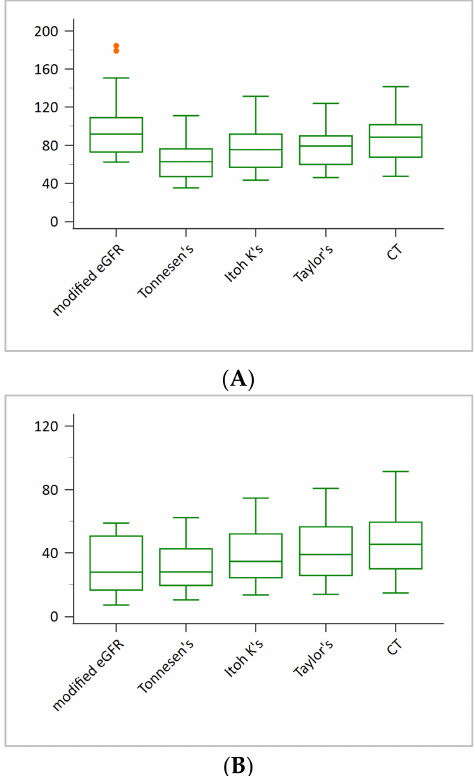
Figure 6. The boxplots for comparison of the GFRs calculated by Tonnesen’s, Itoh K’s, Taylor’s formula, CT scan, and the modified eGFR. ( A ), patients with modified eGFR more than 60 mL/min. ( B ), patients with modified eGFR less than 60